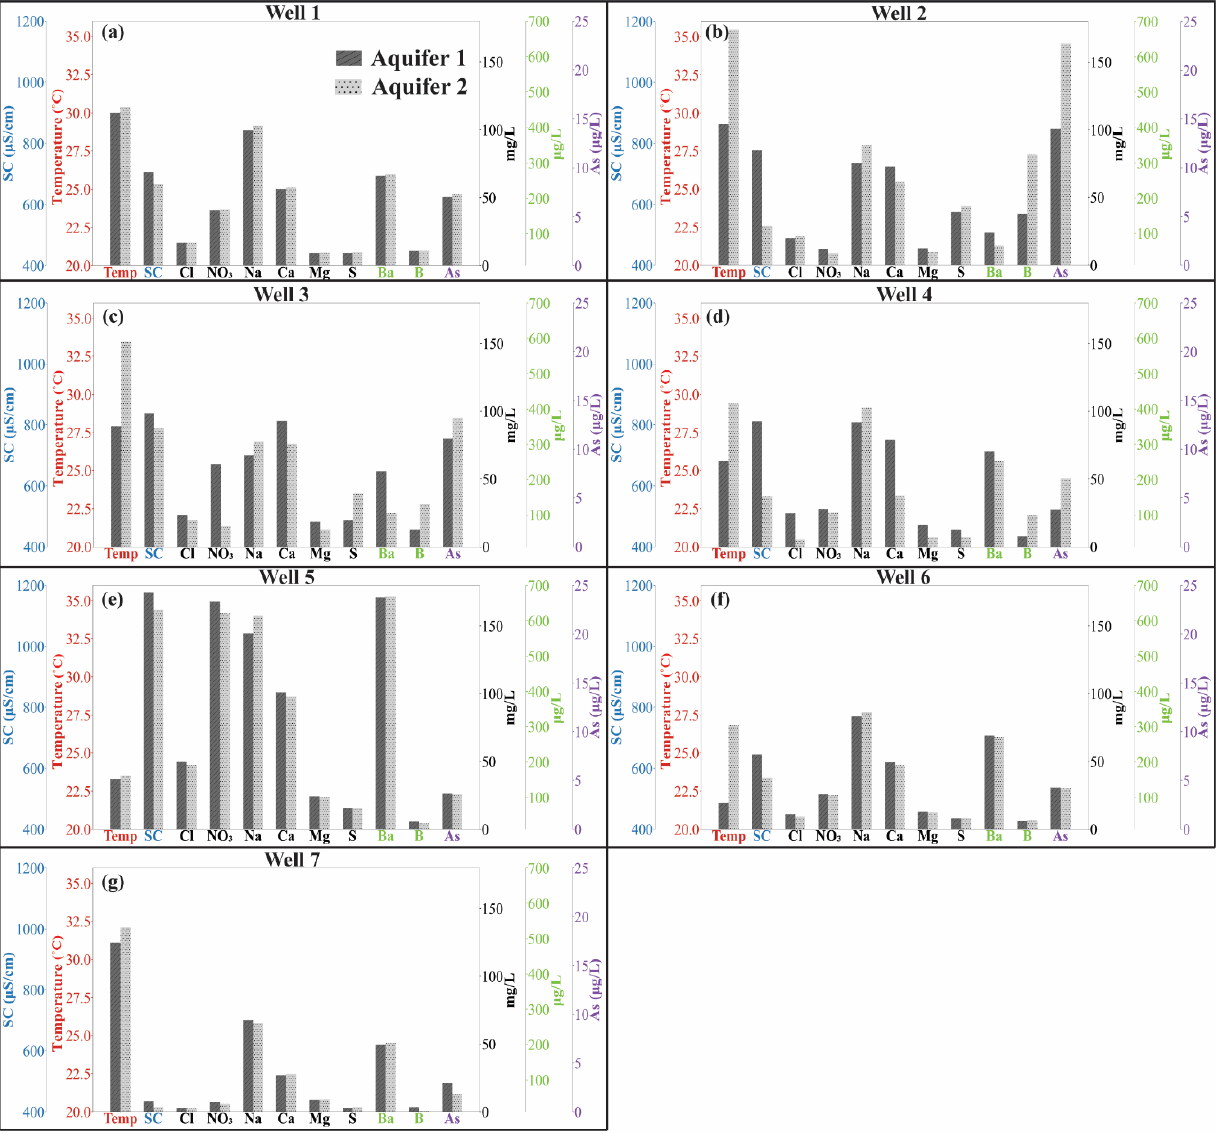
Figure 6. The water chemistry of conservative constituents (temperature, SC, Cl, NO 3 , Na, Ca, Mg, S, Ba, B and As) in Aquifer 1 and Aquifer 2 over 7 wells. Panels ( a – g ) indicate Wells 1–7, respectively. The color of tracer’s name on the horizontal axis matches the color of its corresponding vertical axis.